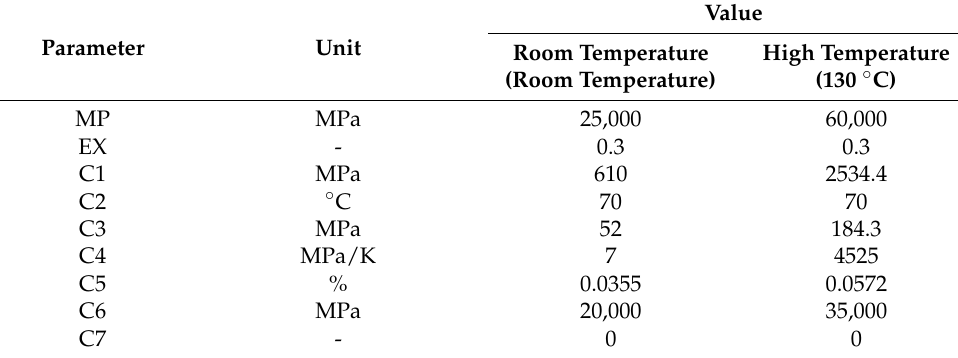
Table 9. Material parameter set for the SMA